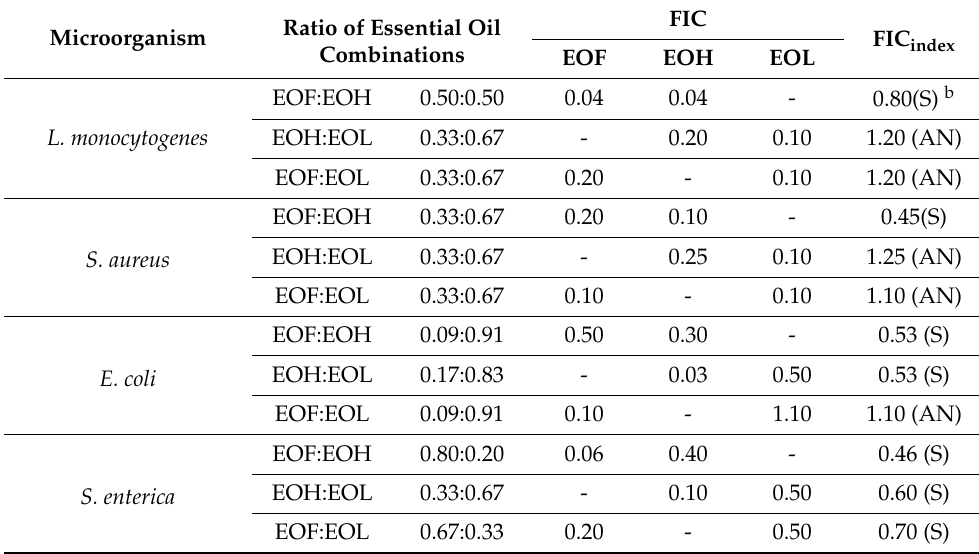
Table 2. Fractional inhibitory concentration index (FIC index ) of EOF, EOH and EOL against L. monocytogenes , S. aureus , E. coli and S. enterica a .